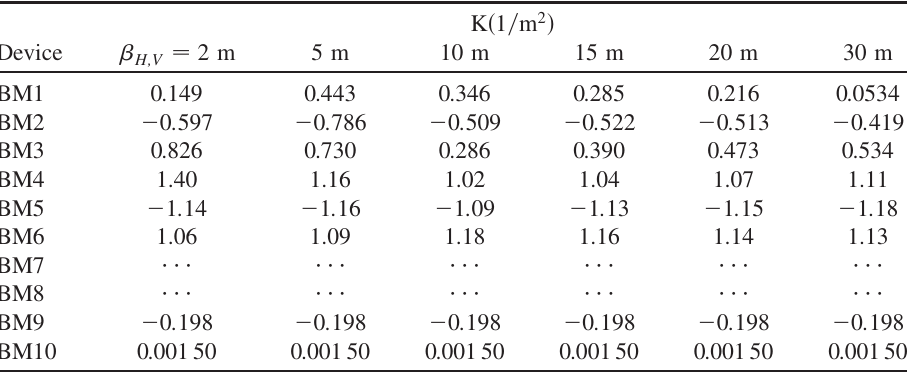
TABLE I. Normalized field gradients of quadrupole magnetic field in the superconducting magnets for various conditions of the final beta, (cid:3) H;V , at the isocenter, as determined by optics- matching calculations. Negative numbers denote the focusing cell.